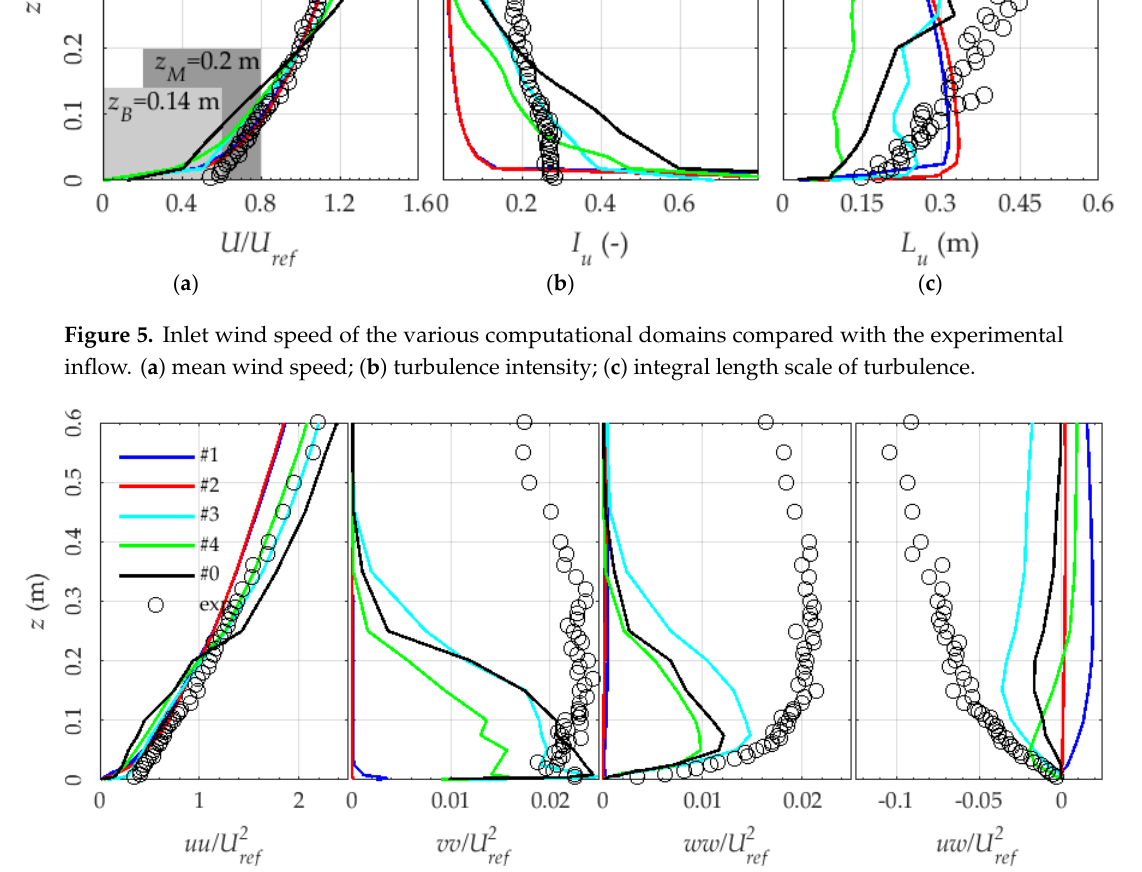
Figure 6. Turbulent Fluxes for the various computational domains compared with the experimental inflow. ( a ) uu , ( b ) vv , ( c ) ww and ( d ) uw normalized against the reference velocity U ref .